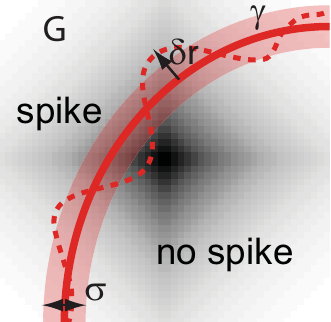
Figure 1. Schematic illustration of a hypothetical decision boundary relative to the input probability distribution, shown as a color plot. In this case, the decision boundary (red solid line) is shown as extending to infinity, but closed contours are also possible. Variations in contours’ shape (as illustrated with a dashed curve) not only shift the position of the decision boundary relatively to the input probability distribution, but also change the overall length of the contour and its infinitesimal arc length